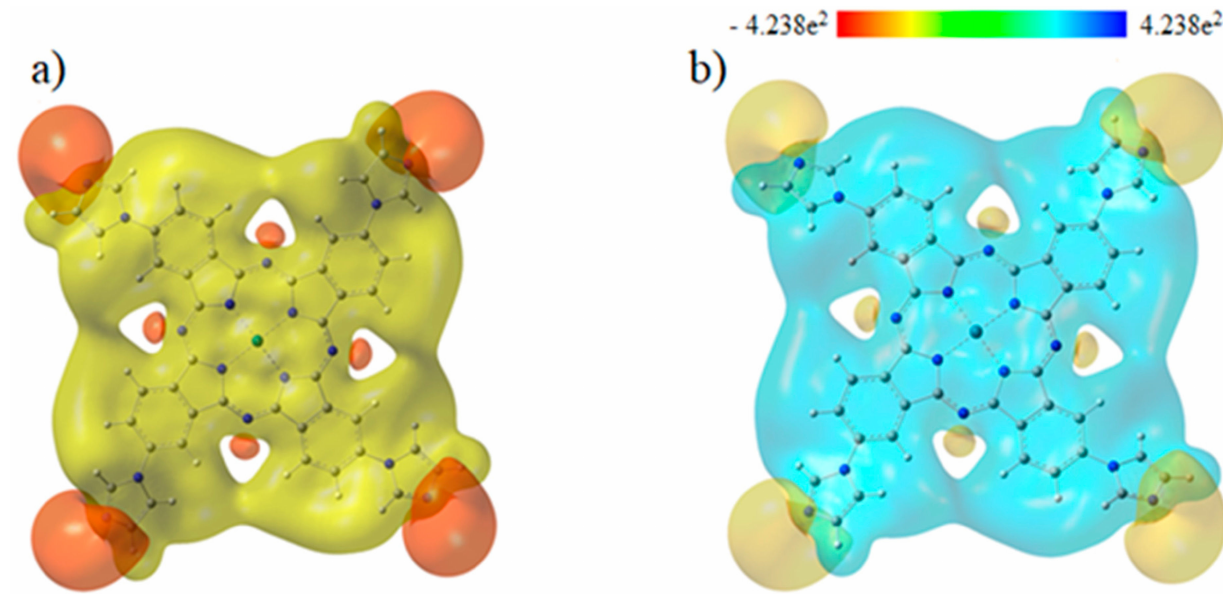
Figure 3. Electrostatic potential surface and contours of PdPc(Im)4: ( a ) from total SCF density (isoval = 0.025); (yellow = positive, orange = negative) and ( b ) mapped with ESP.